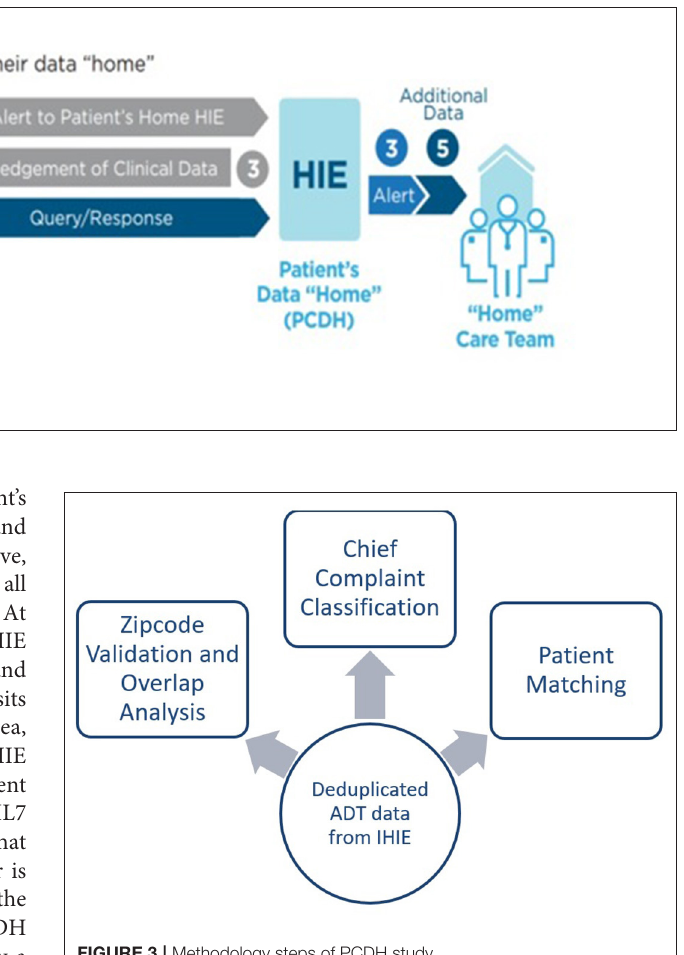
FIGURE 3 | Methodology steps of PCDH